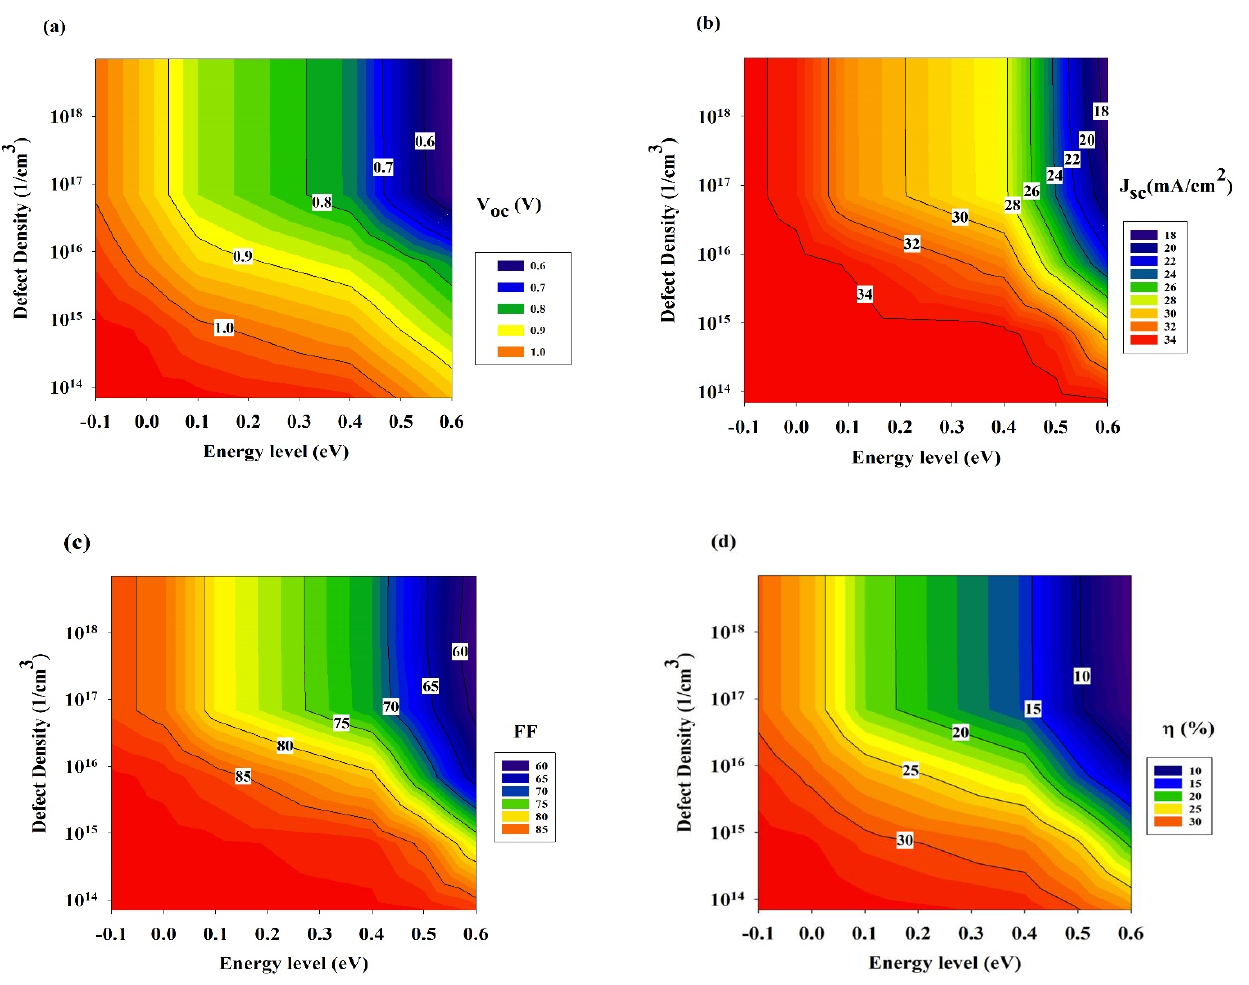
Figure 4. Photovoltaic performance parameters at various defect density as: ( a ) V oc , ( b ) J sc , ( c ) FF, and ( d ) efficiency.